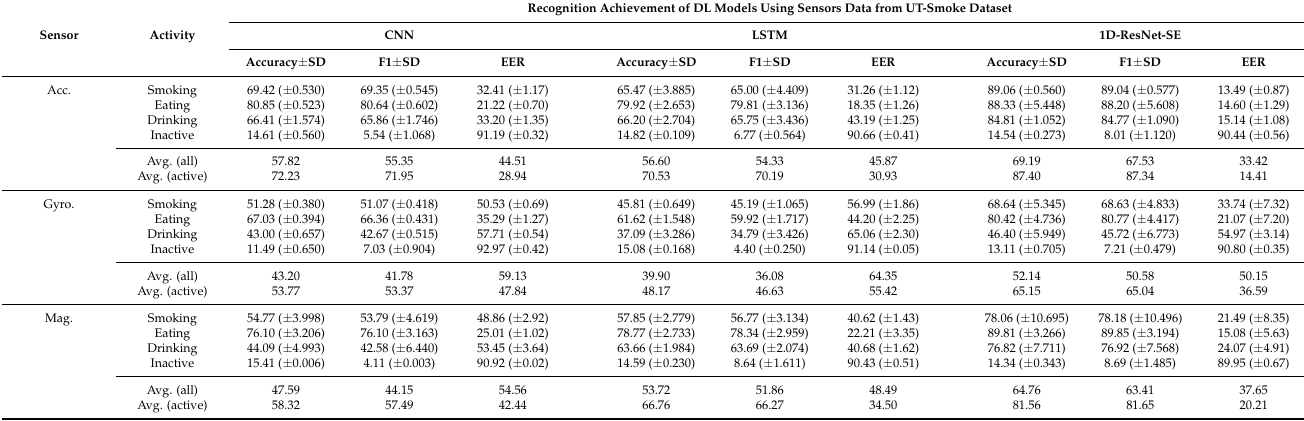
Table 4. Identification effectiveness on classifier evaluation of deep learning models using various combinations of sensor data from UT-Smoke